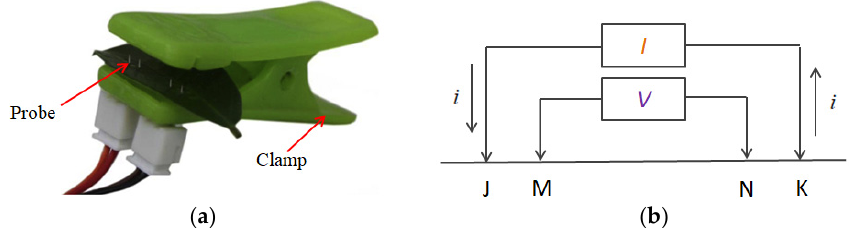
Figure 10. Four-electrode detector structure and scheme: ( a ) four-electrode probe detection device; ( b ) circuit diagram of four-electrode probe detection device.